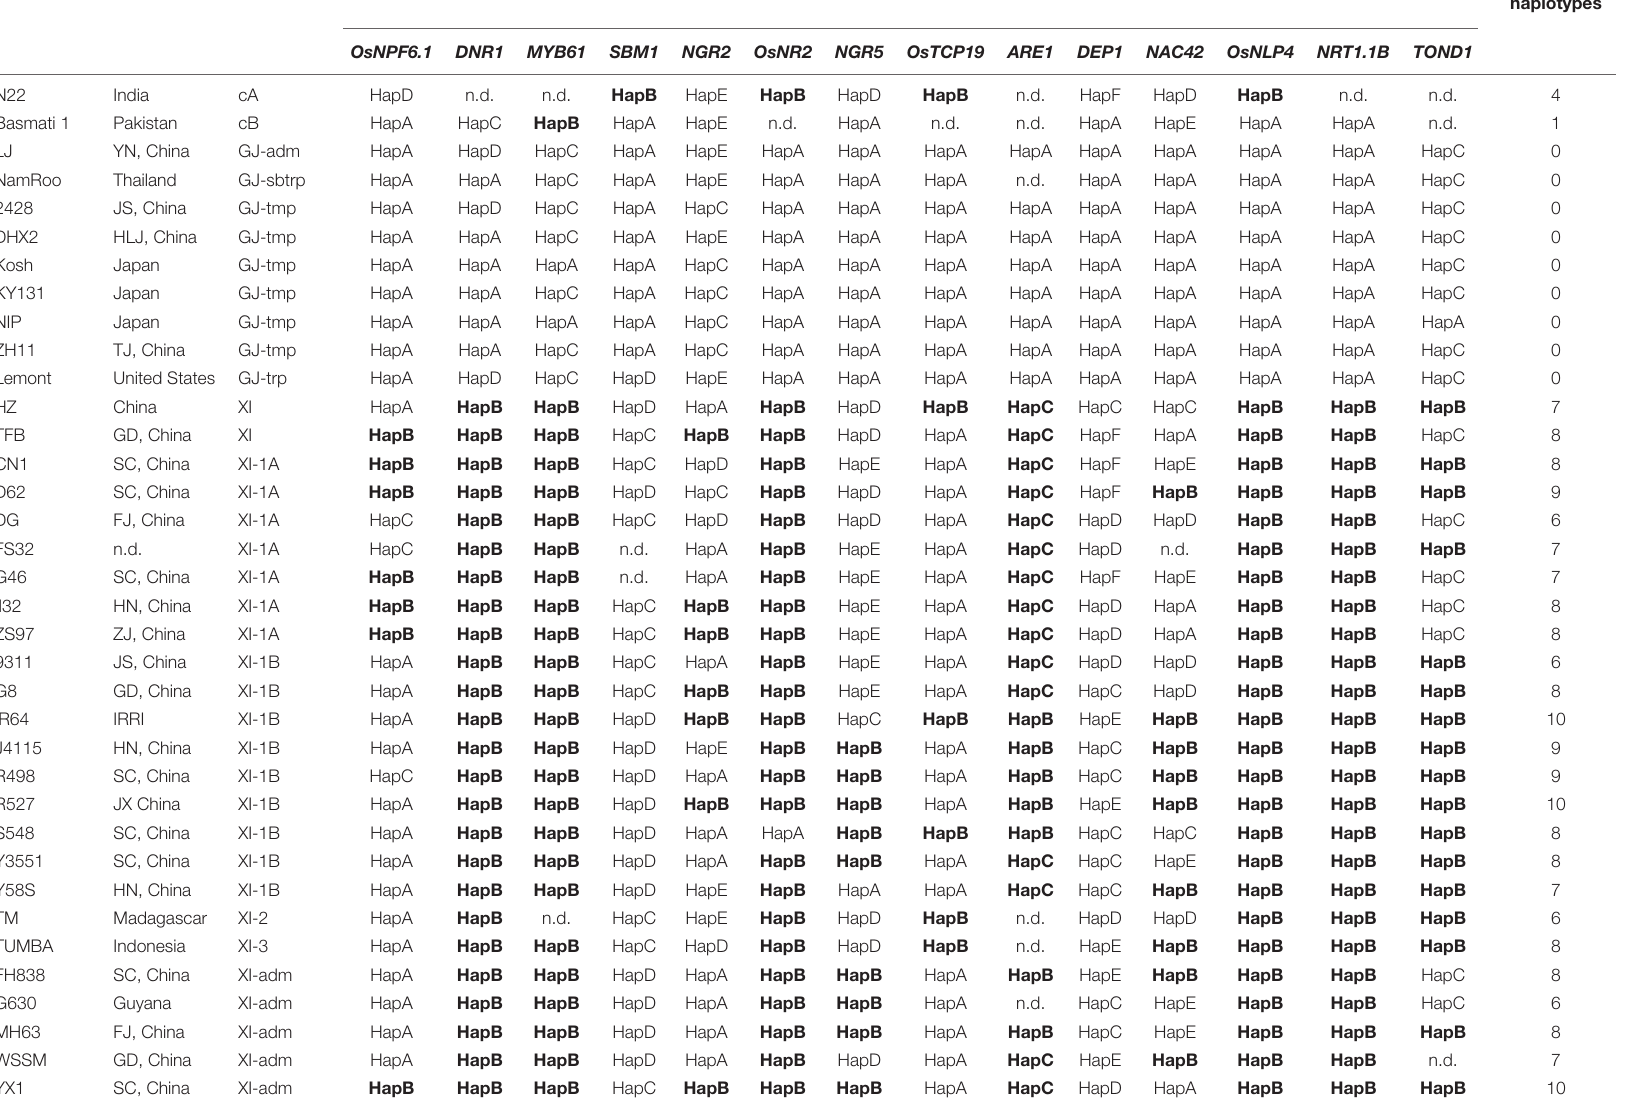
TABLE 2 | Haplotypes of 14 NUE genes in the 36 rice accessions with reference genome. Accessions Orign